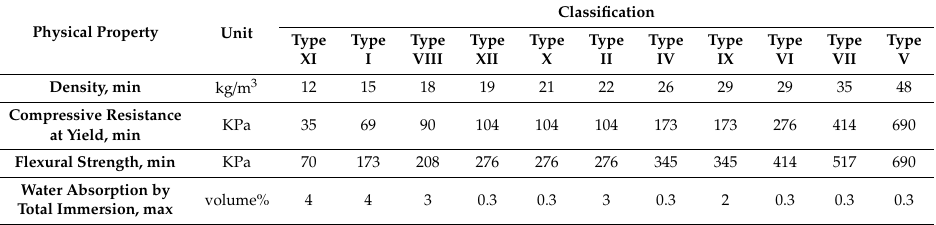
Figure 3. Expanded polystyrene beads. Table 5. Physical characteristics of EPS-beads according to ASTM C-578.